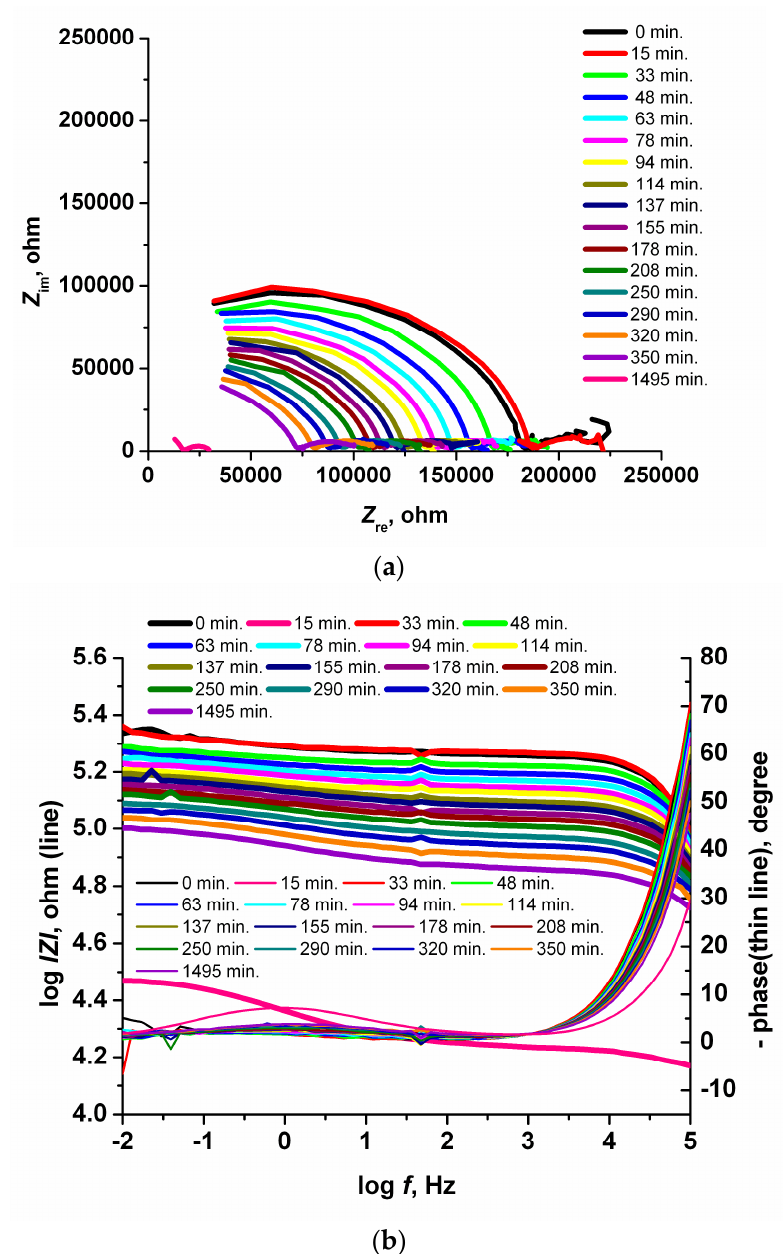
Figure 12. Nyquist ( a ) and Bode ( b ) diagrams in case of NPOE membrane at OCP in MES buffer solution. Figure 12b shows the modulus and the phase angle for the membrane during immersion. The membrane exhibited a well-defined time constant at lower frequencies (the peak in the phase angle plot). Increasing the immersion time the peak seems to move to lower frequencies. Membrane also exhibits a second peak at higher frequencies but this peak extends over the range of measured frequencies (10 5 Hz). The experimental data were fitted to the equivalent electrical circuit by a complex non-linear least squares method, using the ZView-Scribner Associates Inc. (Southern Pines, NC, USA and Solartron Analytical, Oak Ridge, TN, USA) software. The equivalent electric circuit (EEC) used for the NPOE electrode is presented in Figure 13. The obtained results are presented in Table 3 and were used for water absorption investigation.